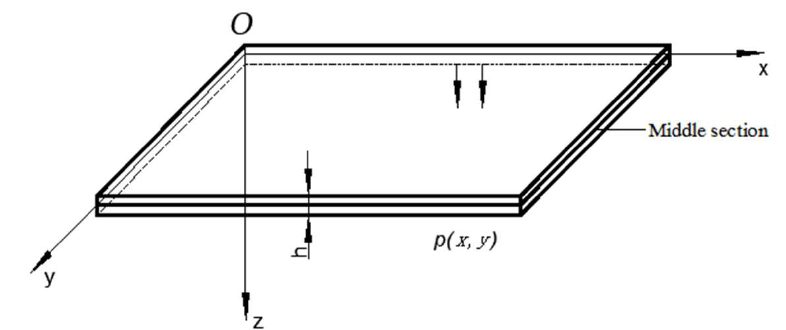
Figure 4. Middle section of thin plate in rectangular coordinate system.